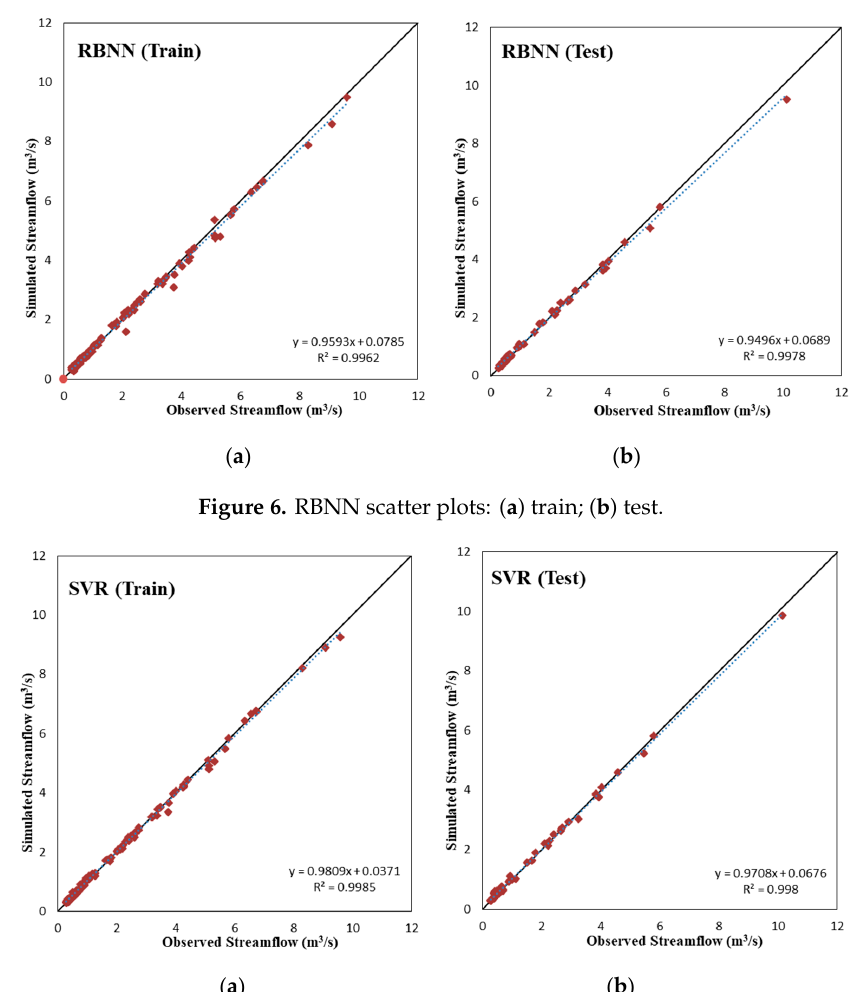
Figure 5. SWAT scatter plots: ( a ) calibration (SUFI-2); ( b ) validation.